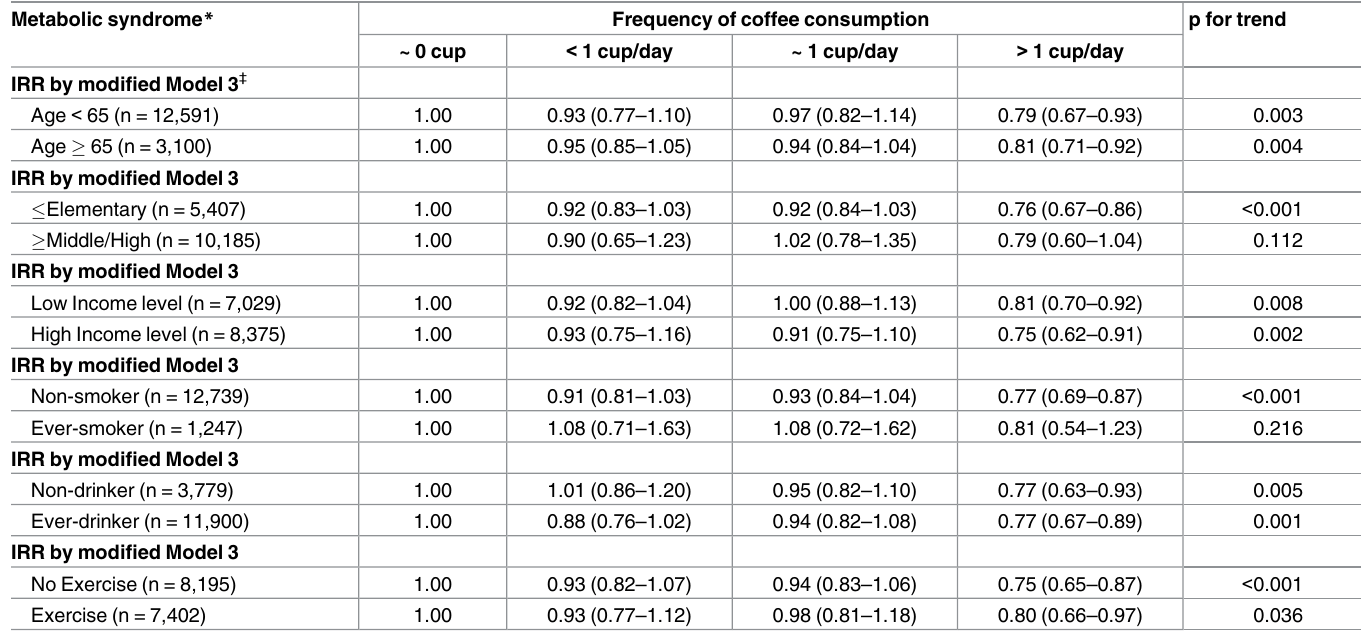
Table 3. The stratification analysis of association between metabolic syndrome and coffee